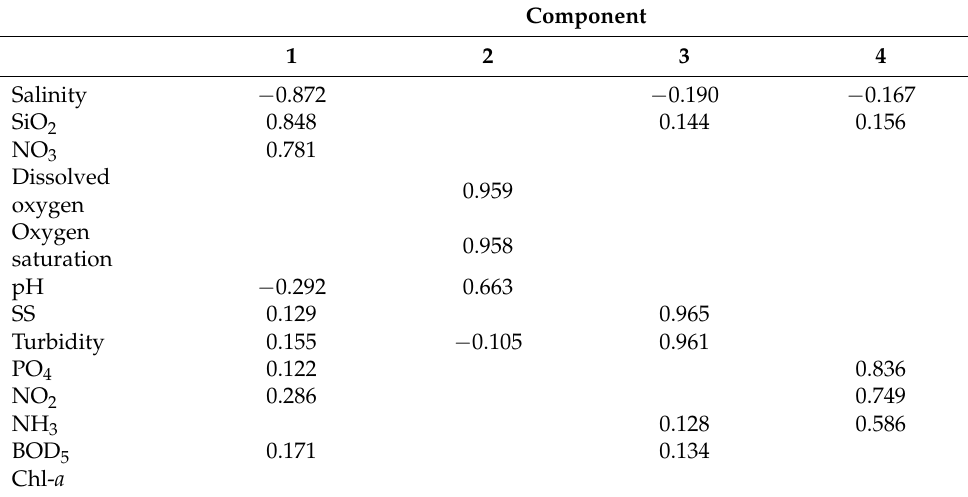
Table 3. PCA loadings of seawater quality